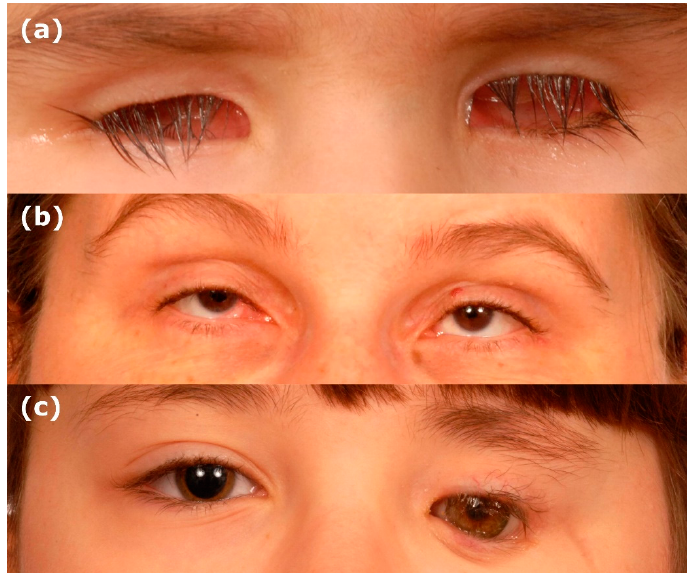
Figure 1. Clinical images of anophthalmia and microphthalmia. ( a ) Bilateral anophthalmia. ( b ) Bilateral microphthalmia. ( c ) Unilateral anophthalmia with shell.